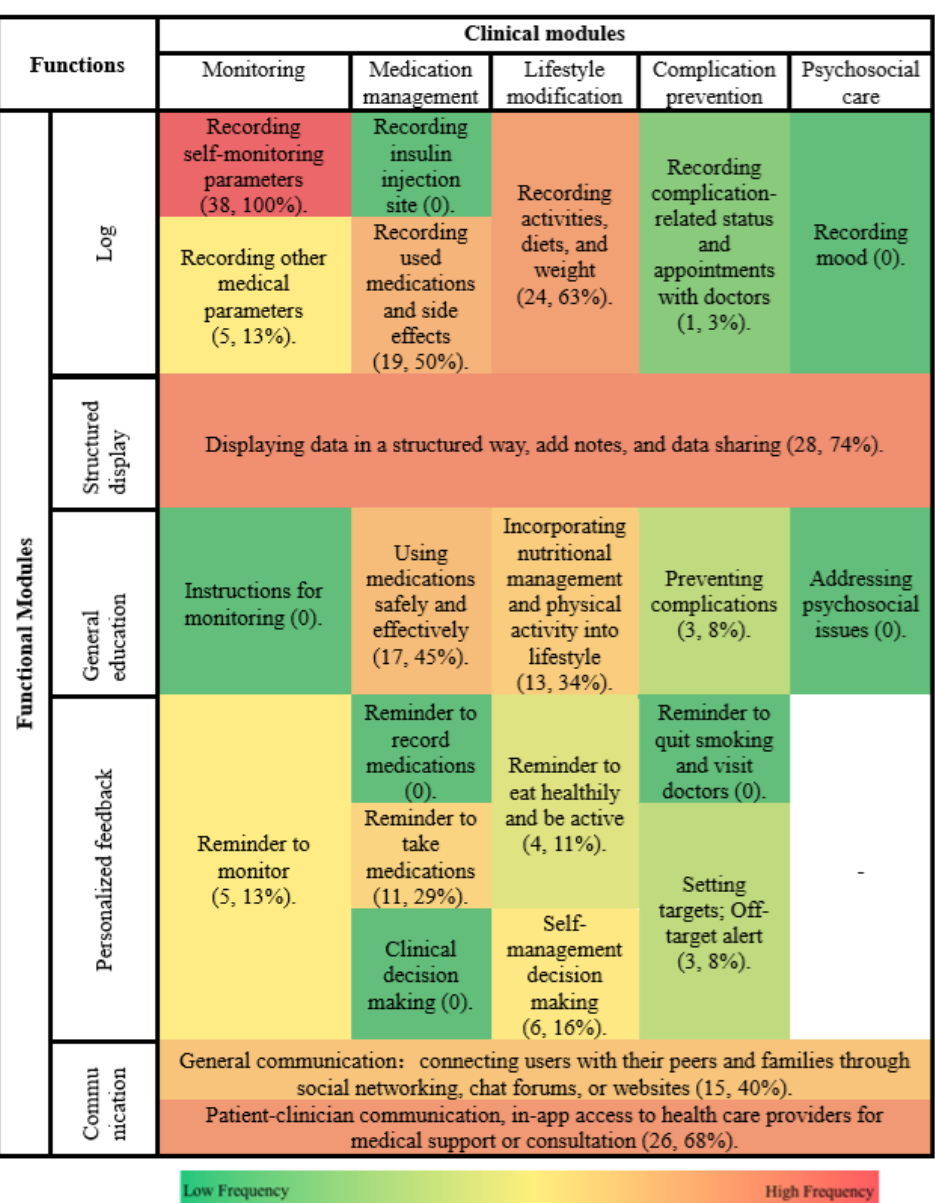
Figure 2. Heatmap of features of 38 Chinese mobile apps for diabetic